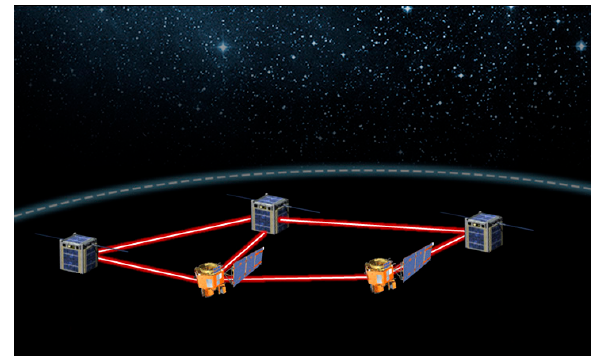
Figure 10. Sketch of an optimized satellite power generation and transfer system. Adapted from https://www.nasa.gov/sites/default/files/thumbnails/image/laser_comm_workshop_image.png.